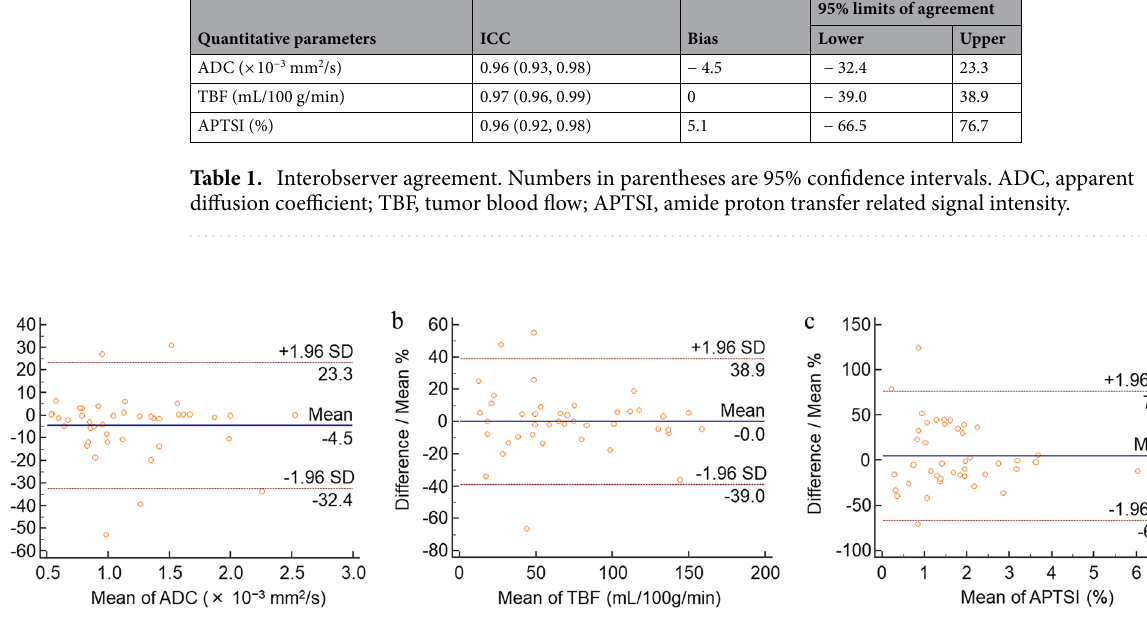
Quantitative parameters